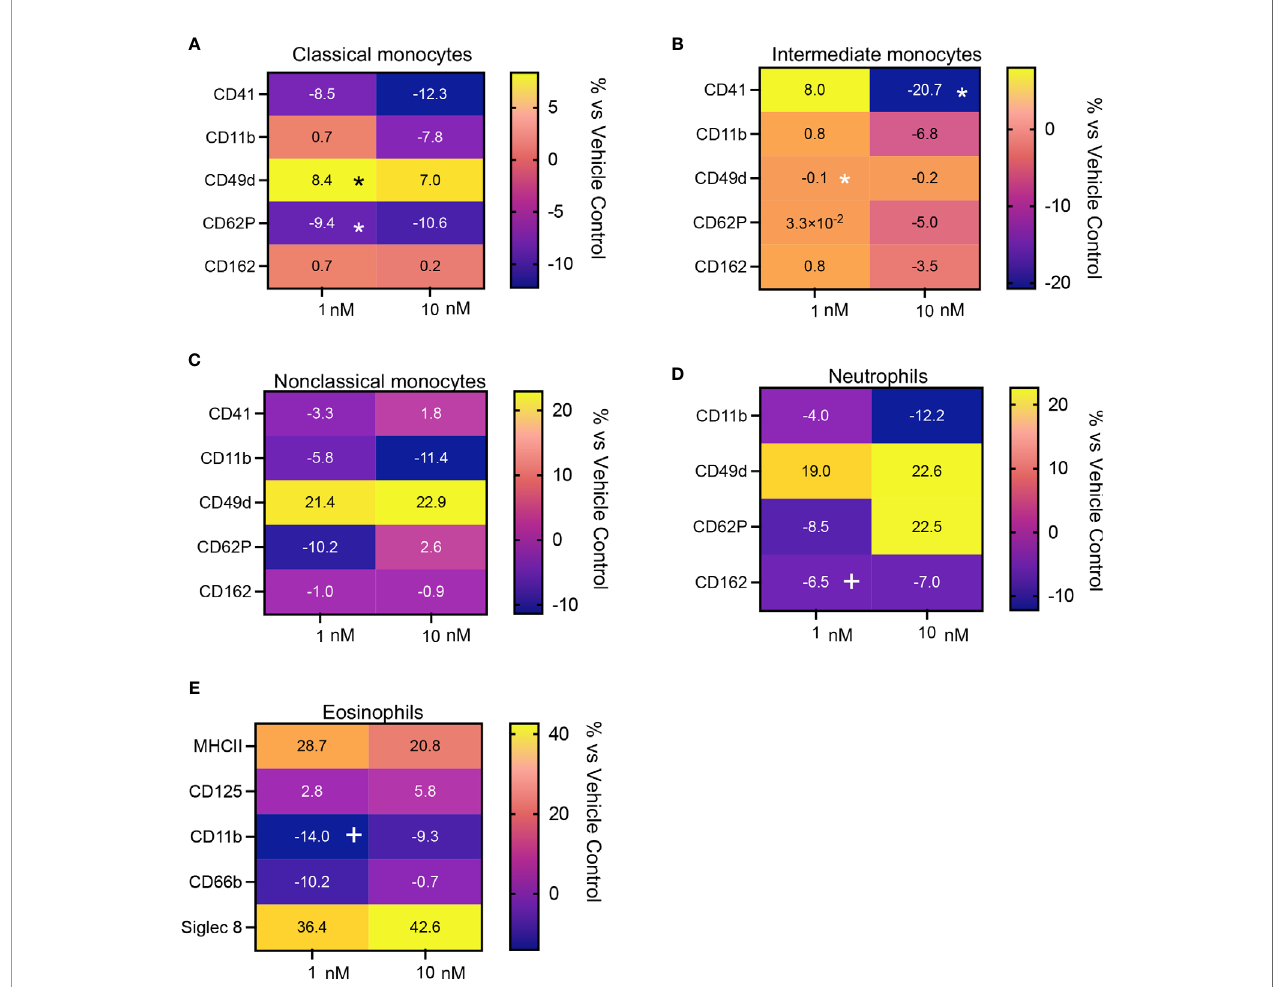
FIGURE 6 | Regulation of activation marker expression in peripheral blood from CRSwNP patients incubated with PAF by MaR1. Peripheral blood from CRSwNP patients was incubated with vehicle or MaR1 (1 or 10nM) for 15 minutes at 37°C then with PAF 100 (nM) for a further 30 minutes at 37°C and the expression of the indicated activation markers was evaluated on (A) CD14++CD16+ Classical monocytes, (B) CD14++CD16++ Intermediate monocytes, (C) CD14+CD16++ Non- Classical monocytes, (D) CD16+ neutrophils and (E) Siglec 8+ eosinophils using fl ow cytometry. Results are means of percentage (%) change from values obtained in vehicle controls for each patient. N = 7 patients for (A – D) and 10 patients for (E) . *p <